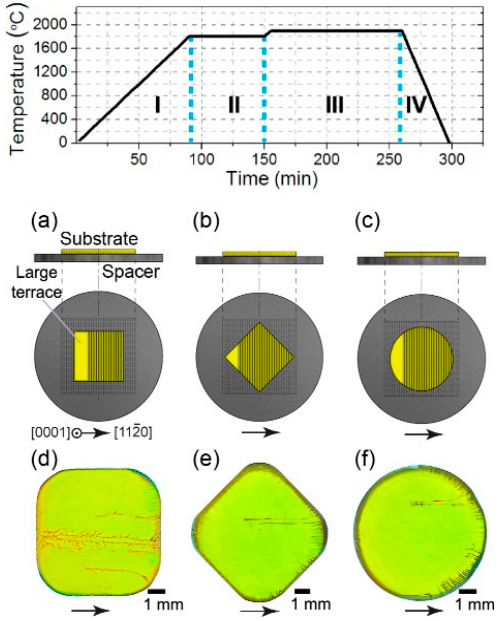
Figure 42. Sketch of two-step growth process of 3C-SiC layers (top). ( a – c ) Schematic illustration of spacer and substrate arrangements. Optical micrographs of the free-standing 3C-SiC grown using ( d ) original, ( e ) 45° rotated, and ( f ) circular spacer openings. Black arrows indicate the step-flow growth direction [151,152].